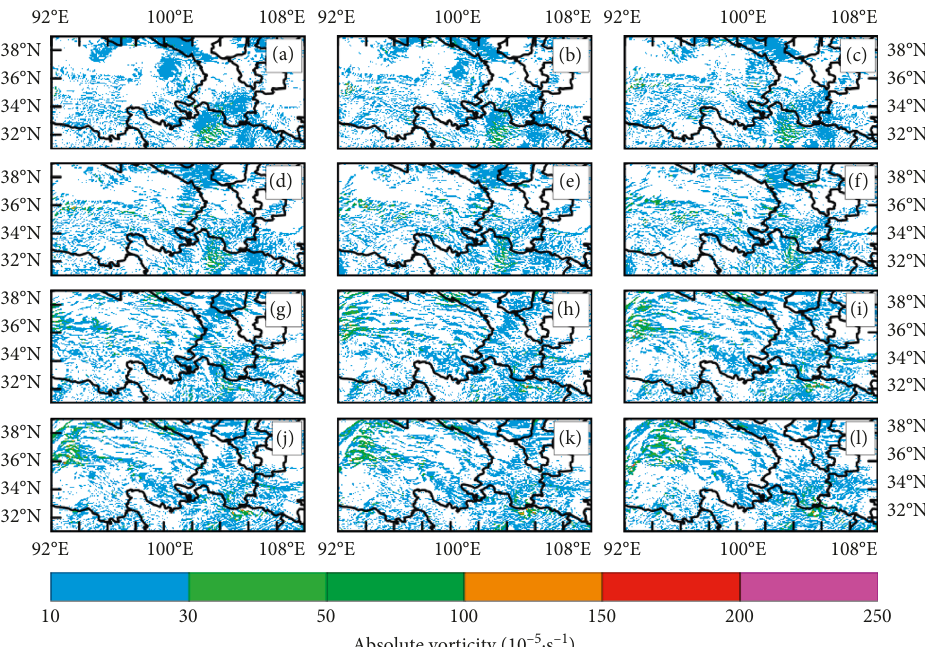
Figure 5: Distribution of absolute vorticity at 8km on June 27: (a) 07:00; (b) 08:00; (c) 09:00; (d) 10:00; (e) 11:00; (f) 12:00; (g) 14:00;